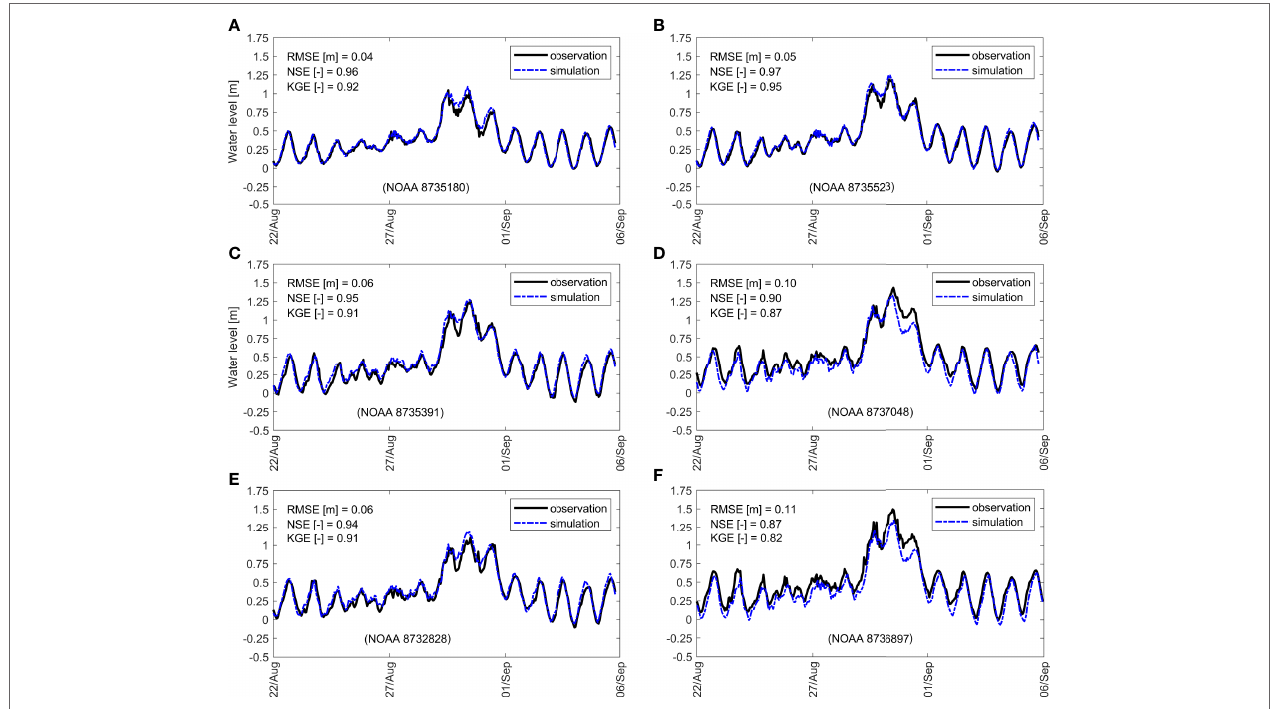
FIGURE 3 | Model calibration of Mobile Bay at tide-gauge (NOAA) stations: (A) Dauphin Island, (B) East Fowl River, (C) Dog River, (D) Mobile State Docks, (E) Weeks Bay, and (F) Coast Guard Mobile. Observed (black solid line) and simulated water levels (blue dashed line) correspond to Hurricane Ida (Aug/Sep 2021). Model performance is evaluated in terms of Root-mean squared error (RMSE), Nash-Sutcliffe efficiency (NSE), and Kling-Gupta efficiency